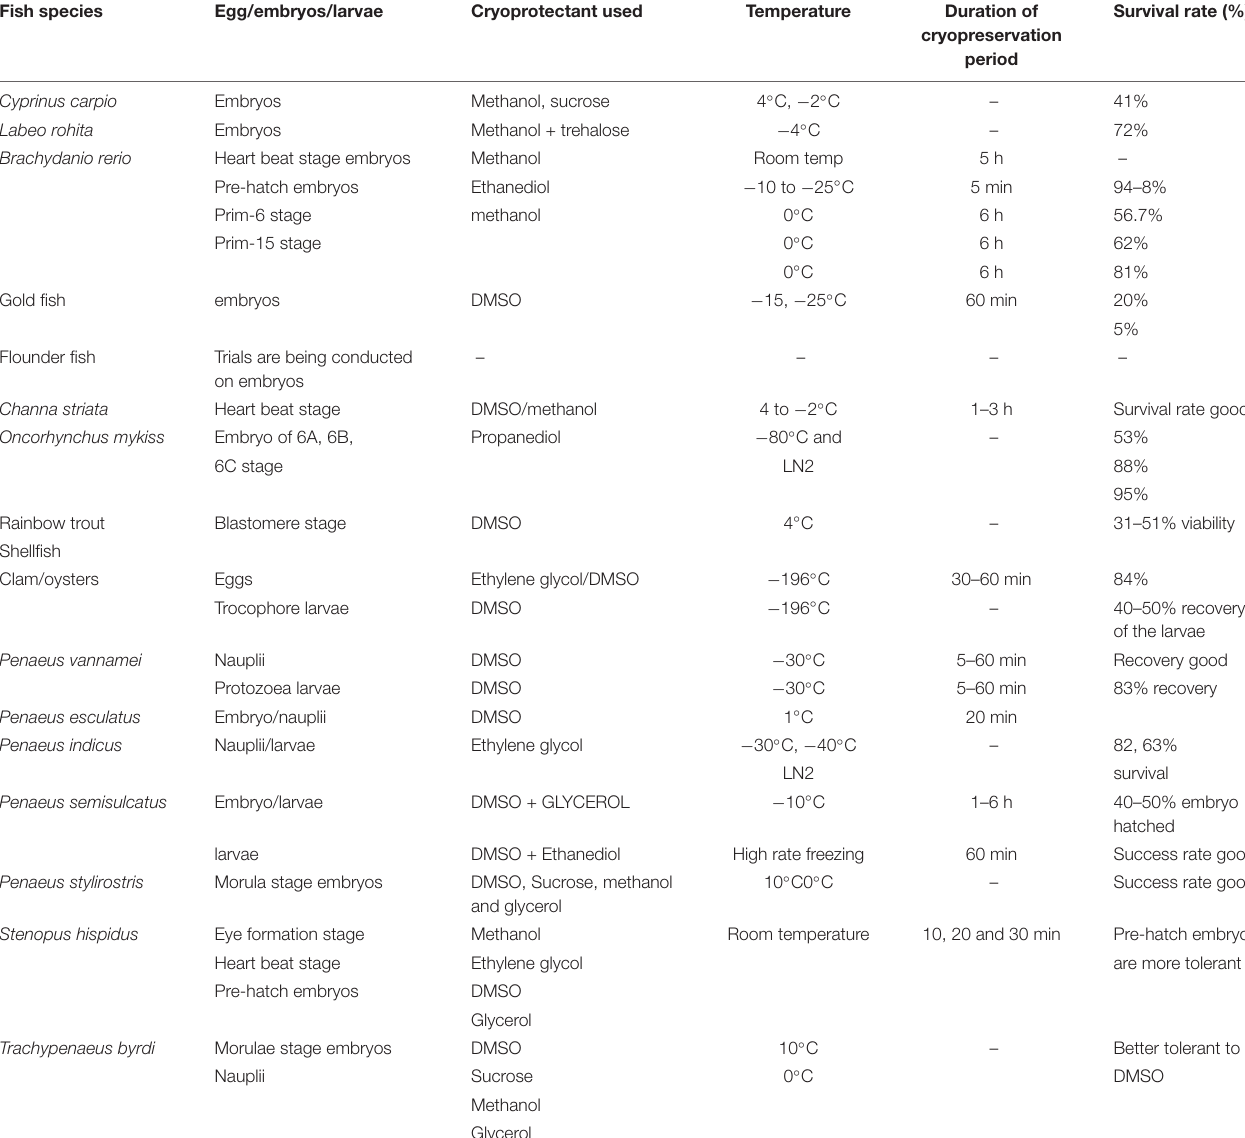
TABLE 1 | Summary of the cryobanking status of fish and shellfish egg, embryos, and larvae. Fish